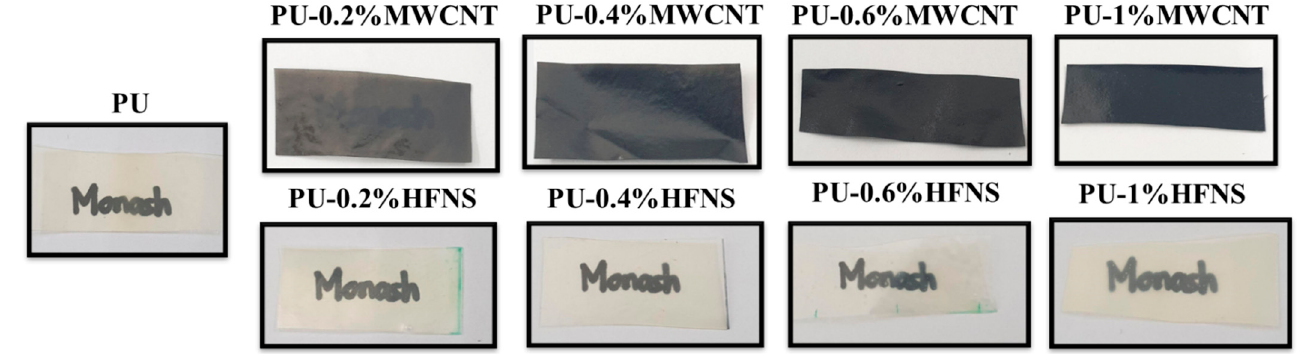
Figure 2. Transparency of polyurea and polyurea nanocomposites thin films.